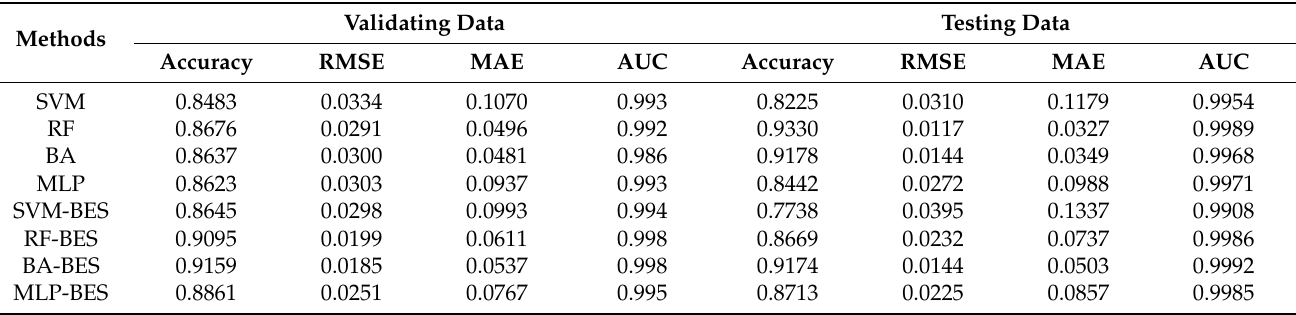
Table 2. Model performance and